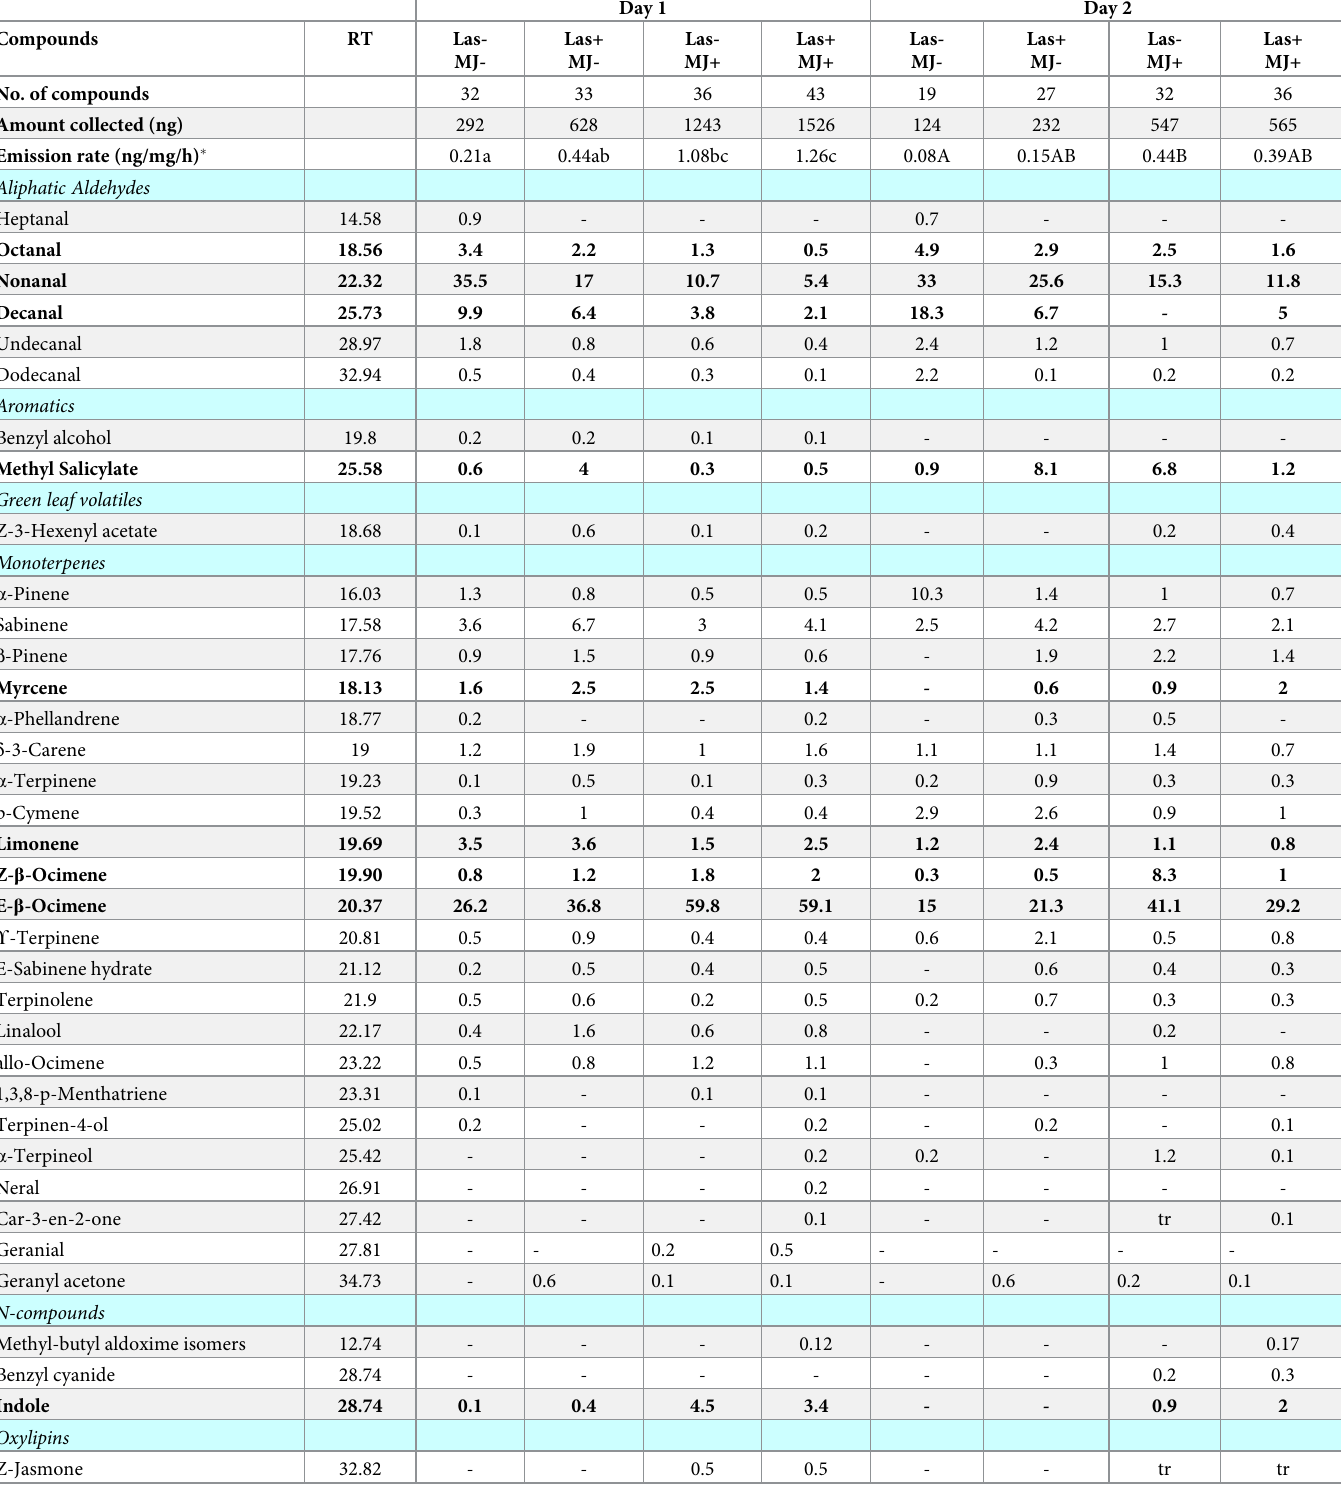
Table 1. Methyl jasmonate experiment results showing mean absolute amounts, emission rates, and relative proportions of volatile compounds collected on two consecutive days from Valencia sweet orange (infected with Las or uninfected; treated with methyl jasmonate or Tween-treated).